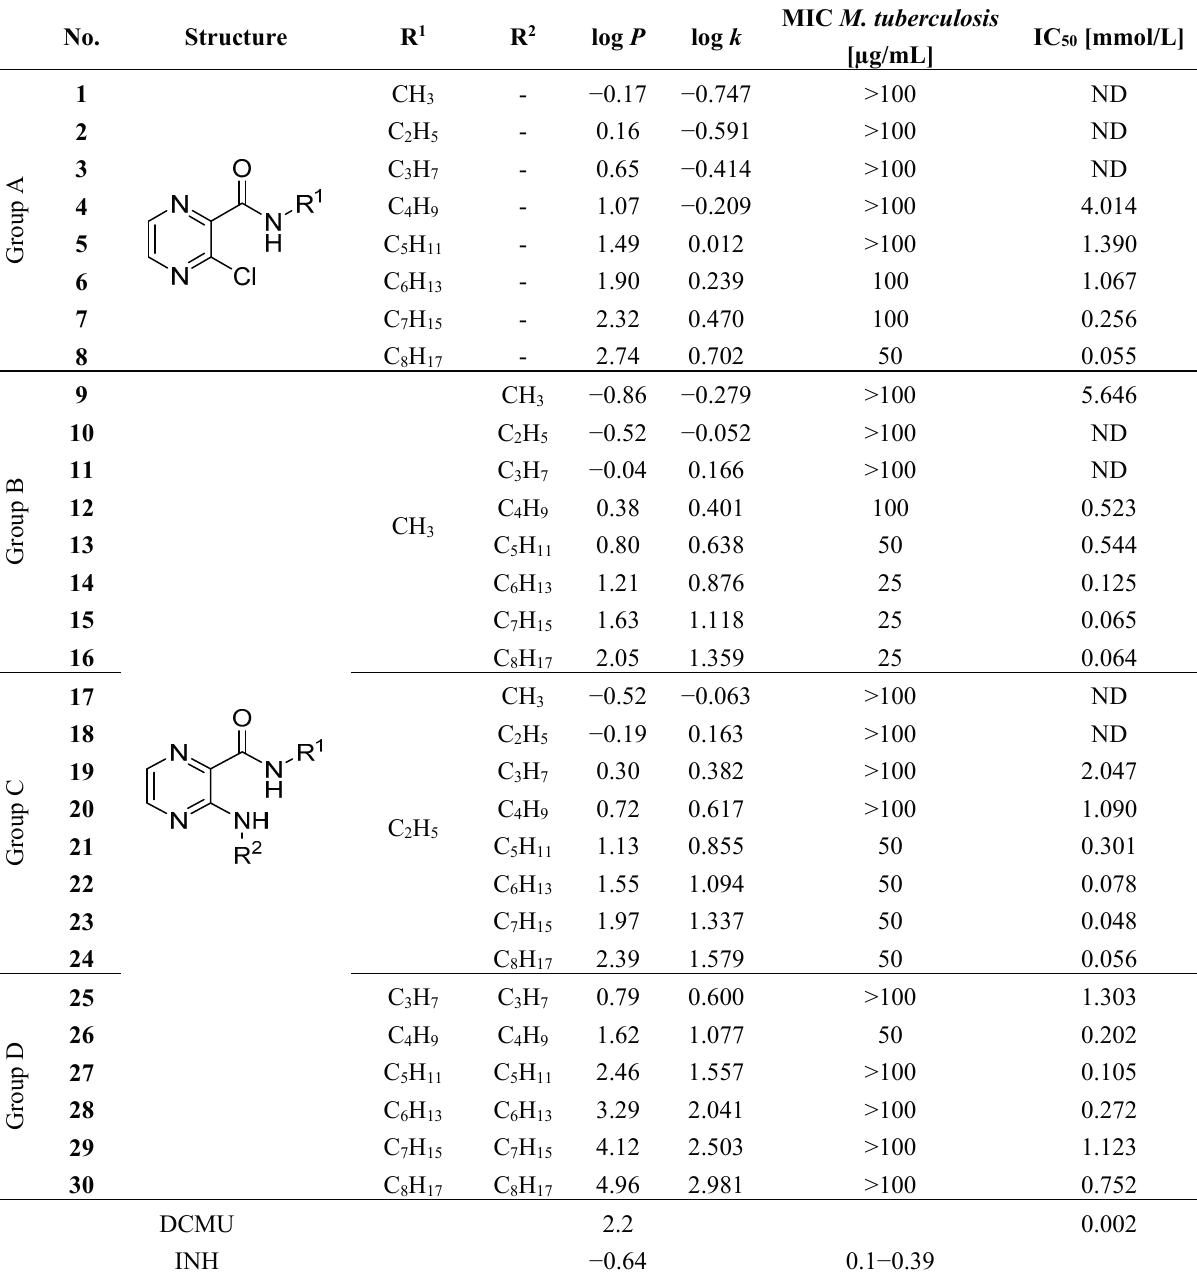
Table 1. Structure of prepared compounds, calculated (log P ) and experimentally measured (log k ) lipophilicity parameters, biological activity against M. tuberculosis H37Rv expressed as minimal inhibitory concentration (MIC) and PET-inhibiting activity expressed by IC 50